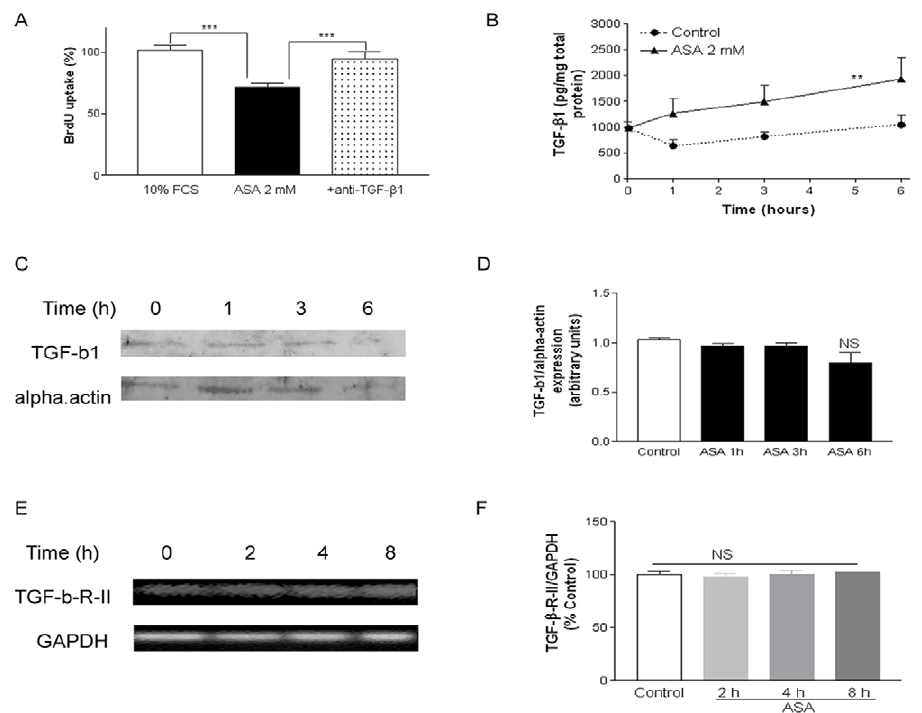
Figure 2. Role of TGF- b 1 in the antiproliferative effect of ASA. Panel A: Anti-TGF- b 1 (50 m g/ml) reversed the antiproliferative effect of ASA (2 mM). Panel B: ASA-mediated secretion of TGF- b 1. Panel C: representative Western blot expression of TGF- b 1 after incubation with ASA 2 mM. Panel D: quantification of Western blot experiments. Panel E: Representative RT-PCR blots for TGF- b -RII mRNA after incubation with ASA 2 mM. Panel F: Quantification of RT-PCR experiments. Bar graphs show the mean 6 S.E.M of n=4 experiments (cell cultures from 4 different patients). ** P , 0.01, *** P , 0.001.